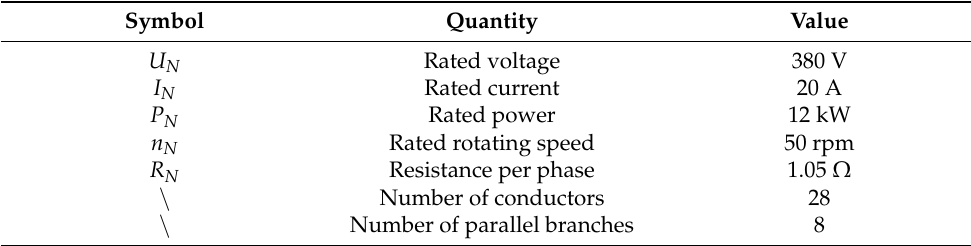
Table 2. Parameters of Prototype